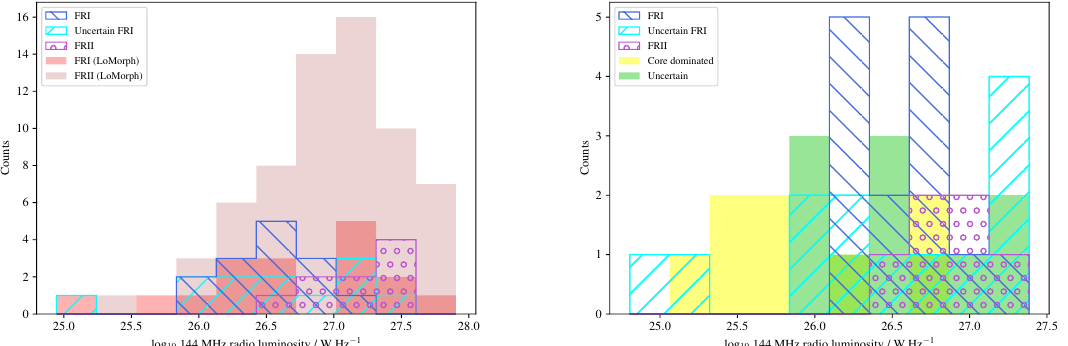
Figure 5. Left-panel : The low-frequency radio luminosity (an indicator for the jet power) histogram of quasars that were included in the pilot survey with the VLA. Right-panel : The low-frequency radio luminosity histogram of quasars that were classified as FRI, FRII and uncertain FRI as part of our pilot study along with FRI and FRII quasars classified by LoMorph. For a clean representation, we show FRII quasars and uncertain FRIIs using the same